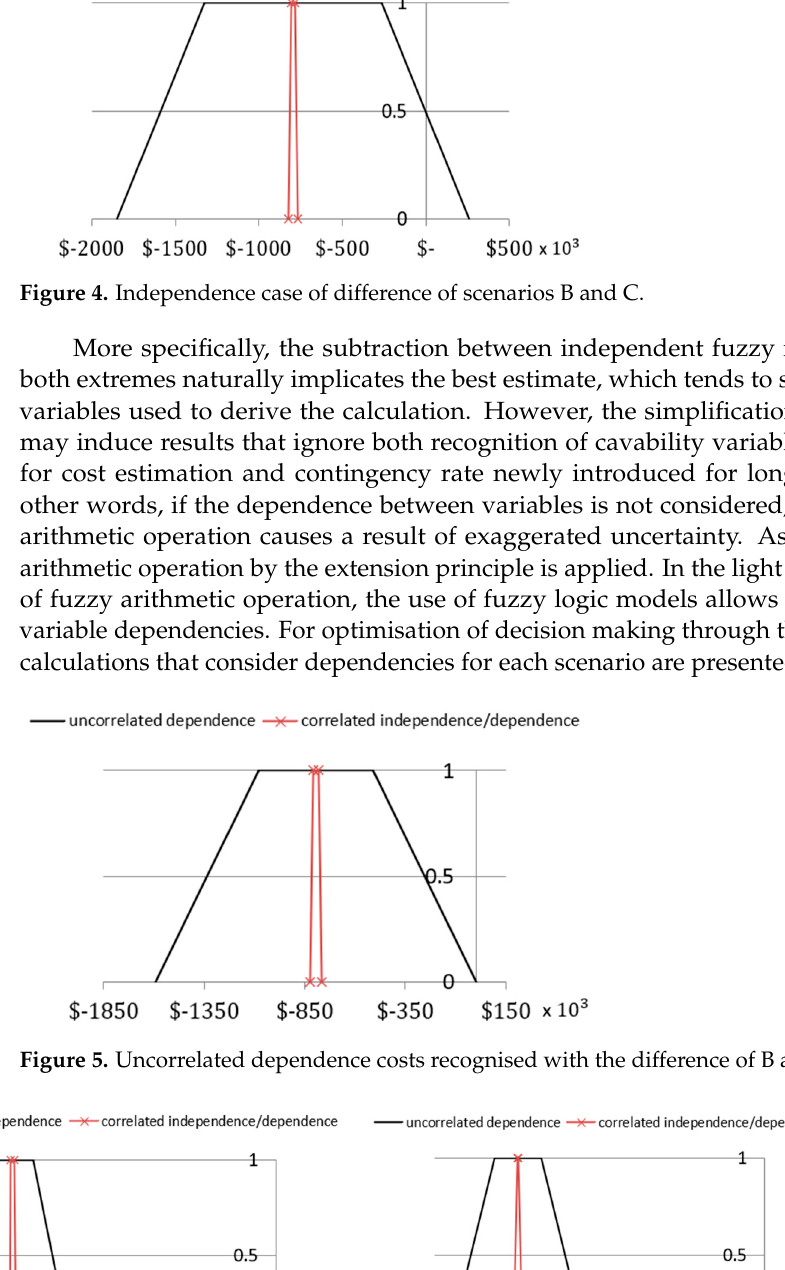
Figure 6. Dependence recognised with the difference of B and A ( Left ) and C and A ( Right ).